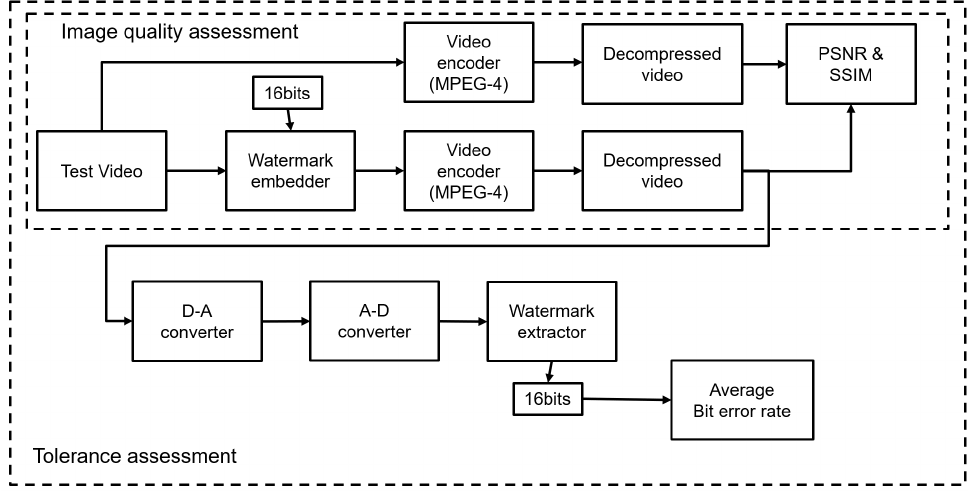
Figure 4. Overall test procedure of the proposed video watermarking